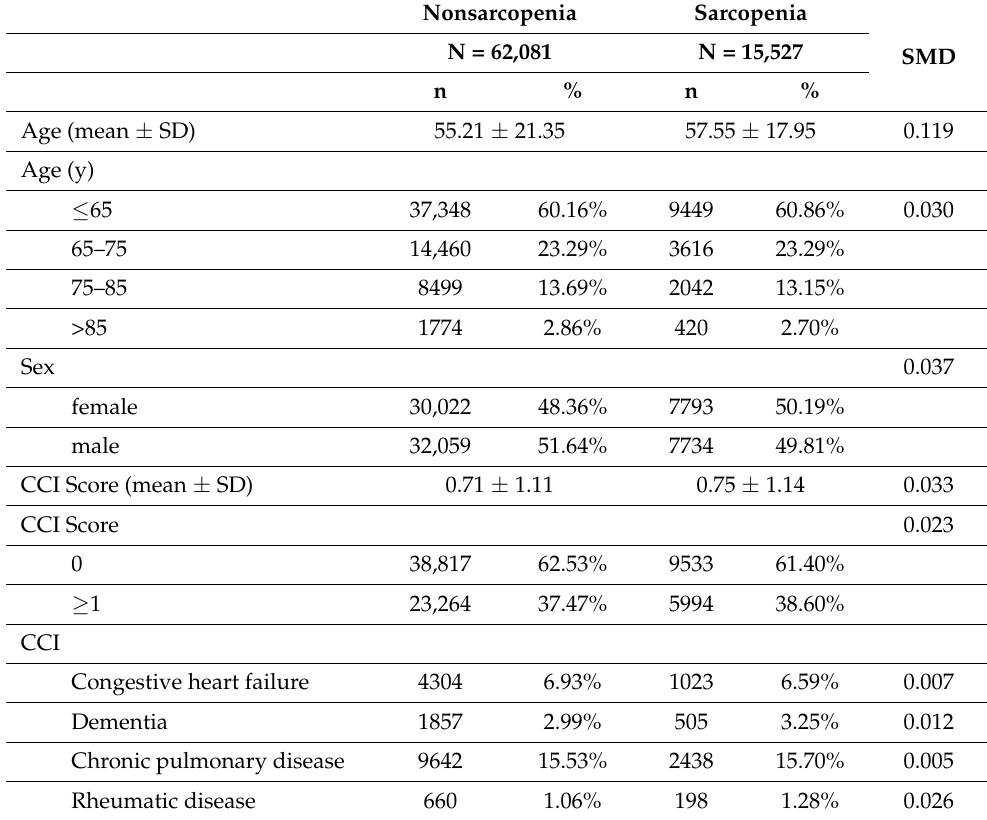
Table 1. Characteristics of PS-matched patients with and without